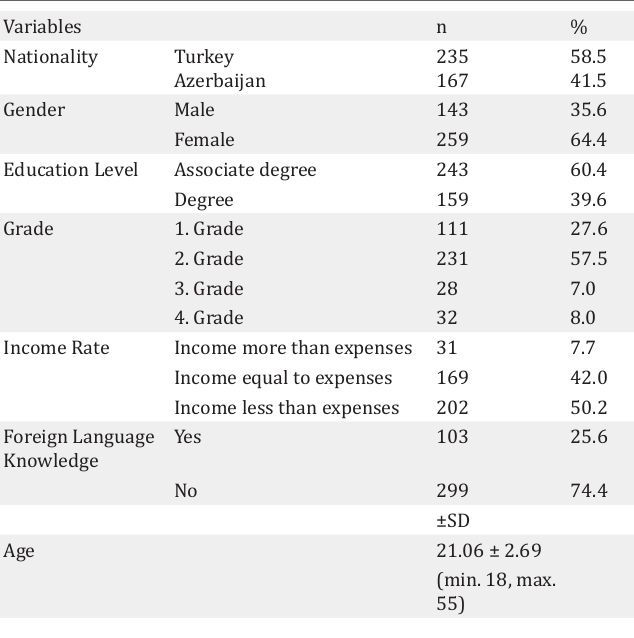
Summary of studies: outcomes, measures, and